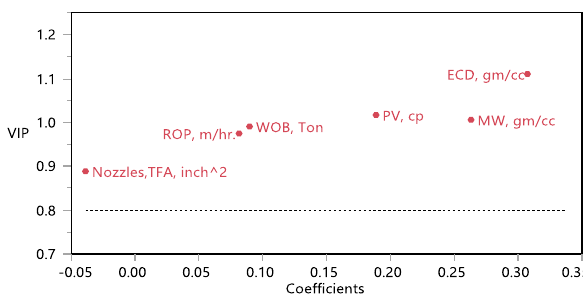
Fig. 8 VIP versus coefficient for volume loss model (before refining)